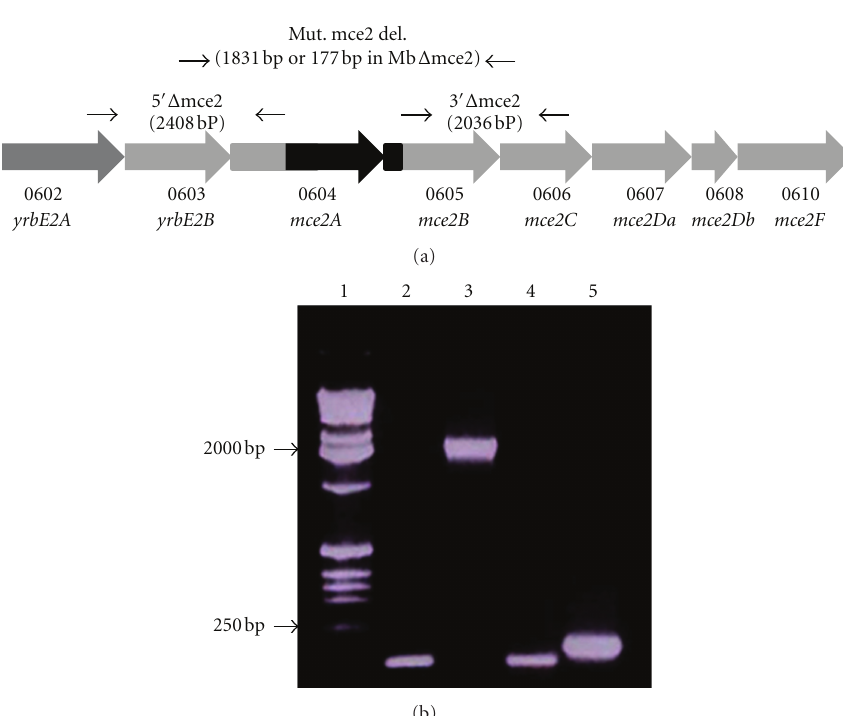
Figure 1: Construction of the M. bovis Δ mce2 mutant strain. (a) An unmarked mutant strain of M. bovis carrying a chromosomal deletion of the region spanning the mce2A-mce2B genes was created by the gene knock-out system described by Parish and Stoker [15]. The mutant strain was designated Mb Δ mce2. (b) PCR analysis of Mb Δ mce2 and the wild type strains. PCRs were performed by using primers that hybridize outside the mce2A-mce2B region (lanes 3 and 5) or in sigA (lanes 2 and 4). Chromosomal DNA from the parental strain (lanes 2 and 3) or from the mutant strain (lanes 4 and 5) was used as template in the PCR reactions. Lane 1 is the molecular weight marker (1Kb ladder Promega).